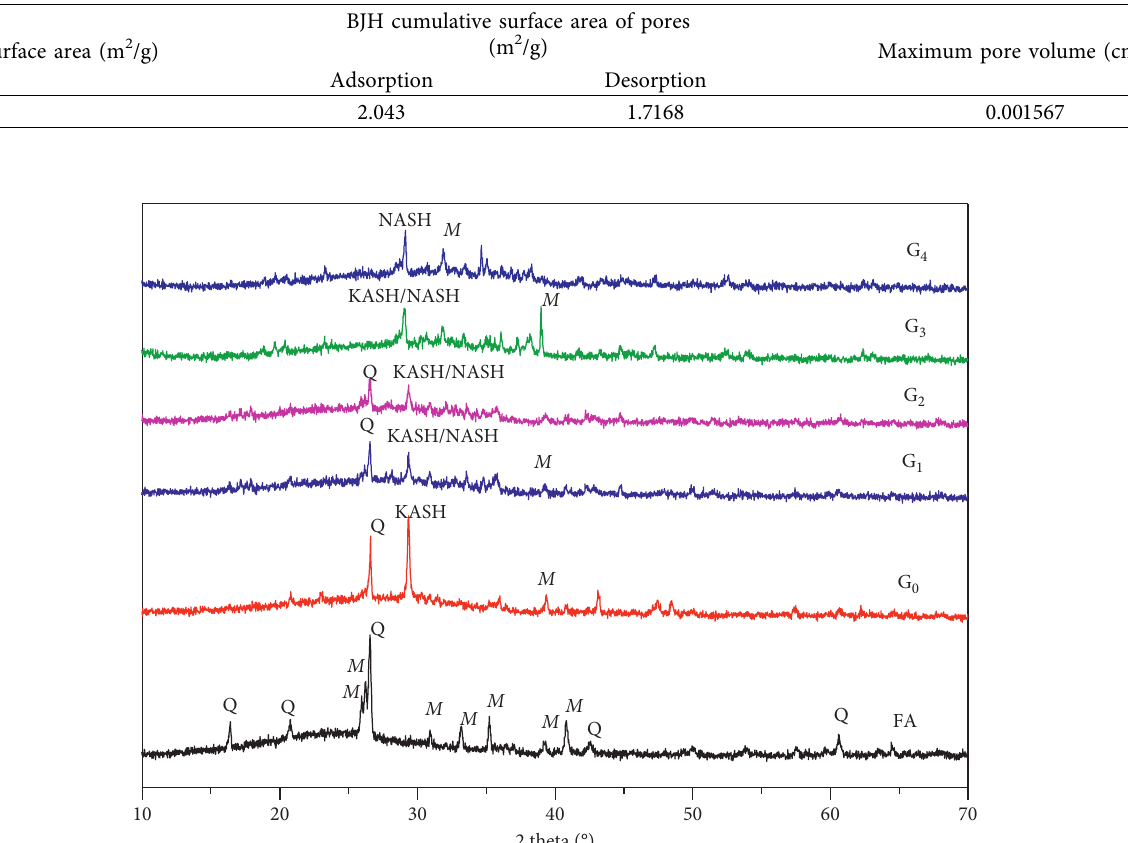
Figure 3: XRD patterns of fly ash and geopolymers dried at room temperature with different ratio of NaOH and KOH (Q: quartz; M: mullite; KASH/NASH: potassium/sodium aluminosilicate hydrate gel).